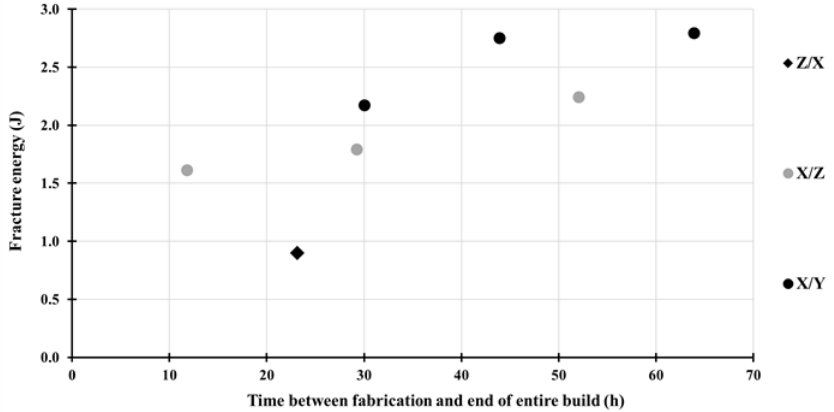
Figure 9. Evolution of toughness impact as a function of remaining time for different building and notch orientations (Area 2).